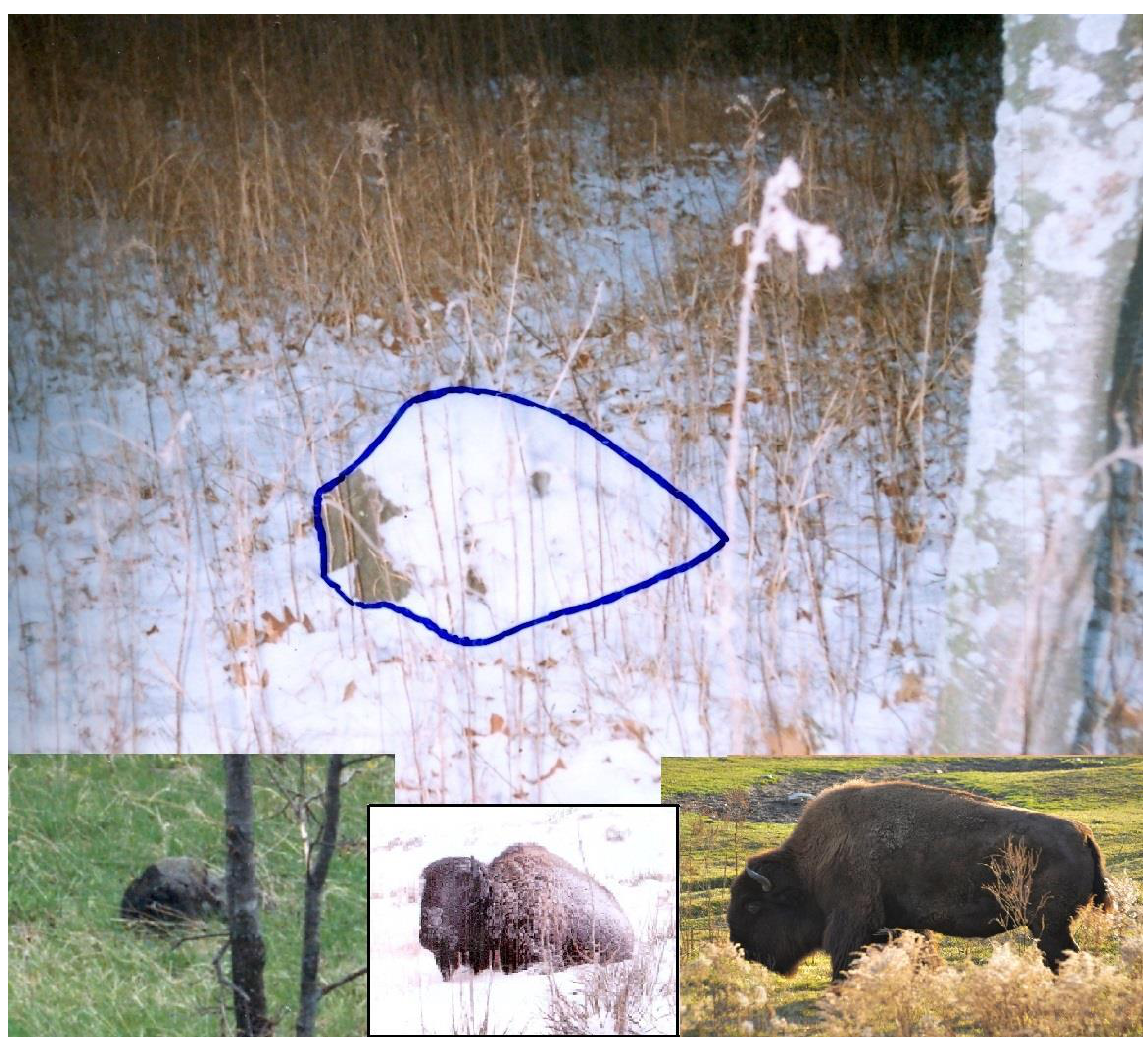
Figure 10. The Starman ‘pelvis’ rock covered in snow and in the tall grass (photo inset at lower left). It is a recumbent bison (photo inset bottom center) effigy aligned to face the summer solstice sunrise (Figure 2). Note the pronounced hump, flat face and head down posture reminiscent of a real bison (photo inset at lower right). It is almost a metre long. View is looking